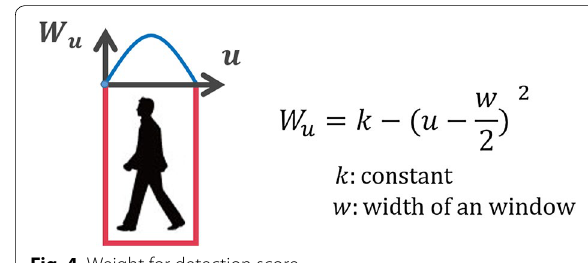
Fig. 4 Weight for detection